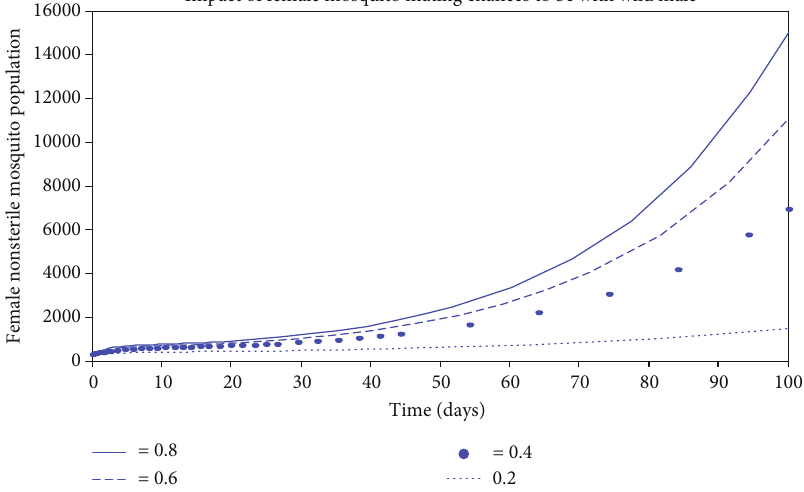
Figure 3: Impact of female mosquito mating probability ð ρ ω Þ to be with the wild male on the female nonsterile mosquitoes; an increment in this rate increases the population of the female nonsterile mosquitoes.